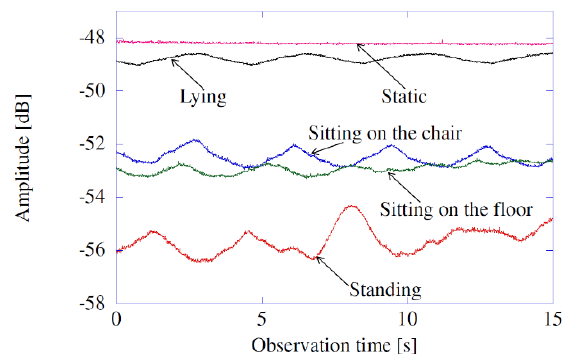
Figure 10. Response of time-variant channel [49].